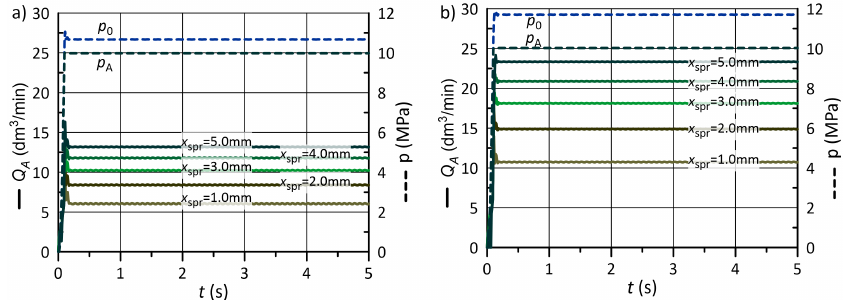
Figure 13. Valve flow rate obtained with fixed load line pressure: ( a ) soft spring ( k spr = 10N mm − 1 ), ( b ) rigid spring ( k spr = 40N mm − 1